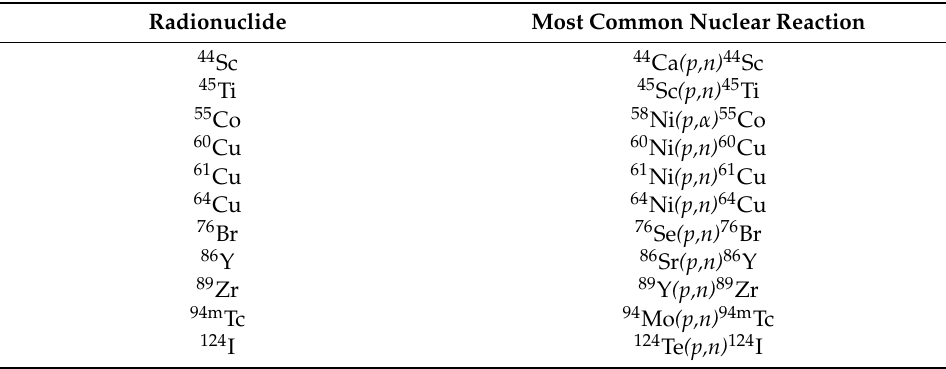
Table 2. Examples of cyclotron-produced unconventional PET radionuclides.